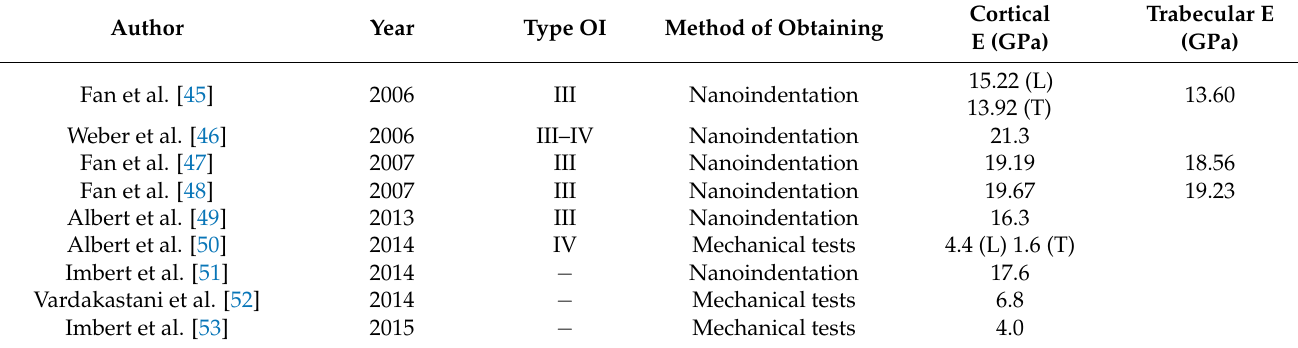
Table 2. Mechanical properties of the bone tissue with OI for the cortical and